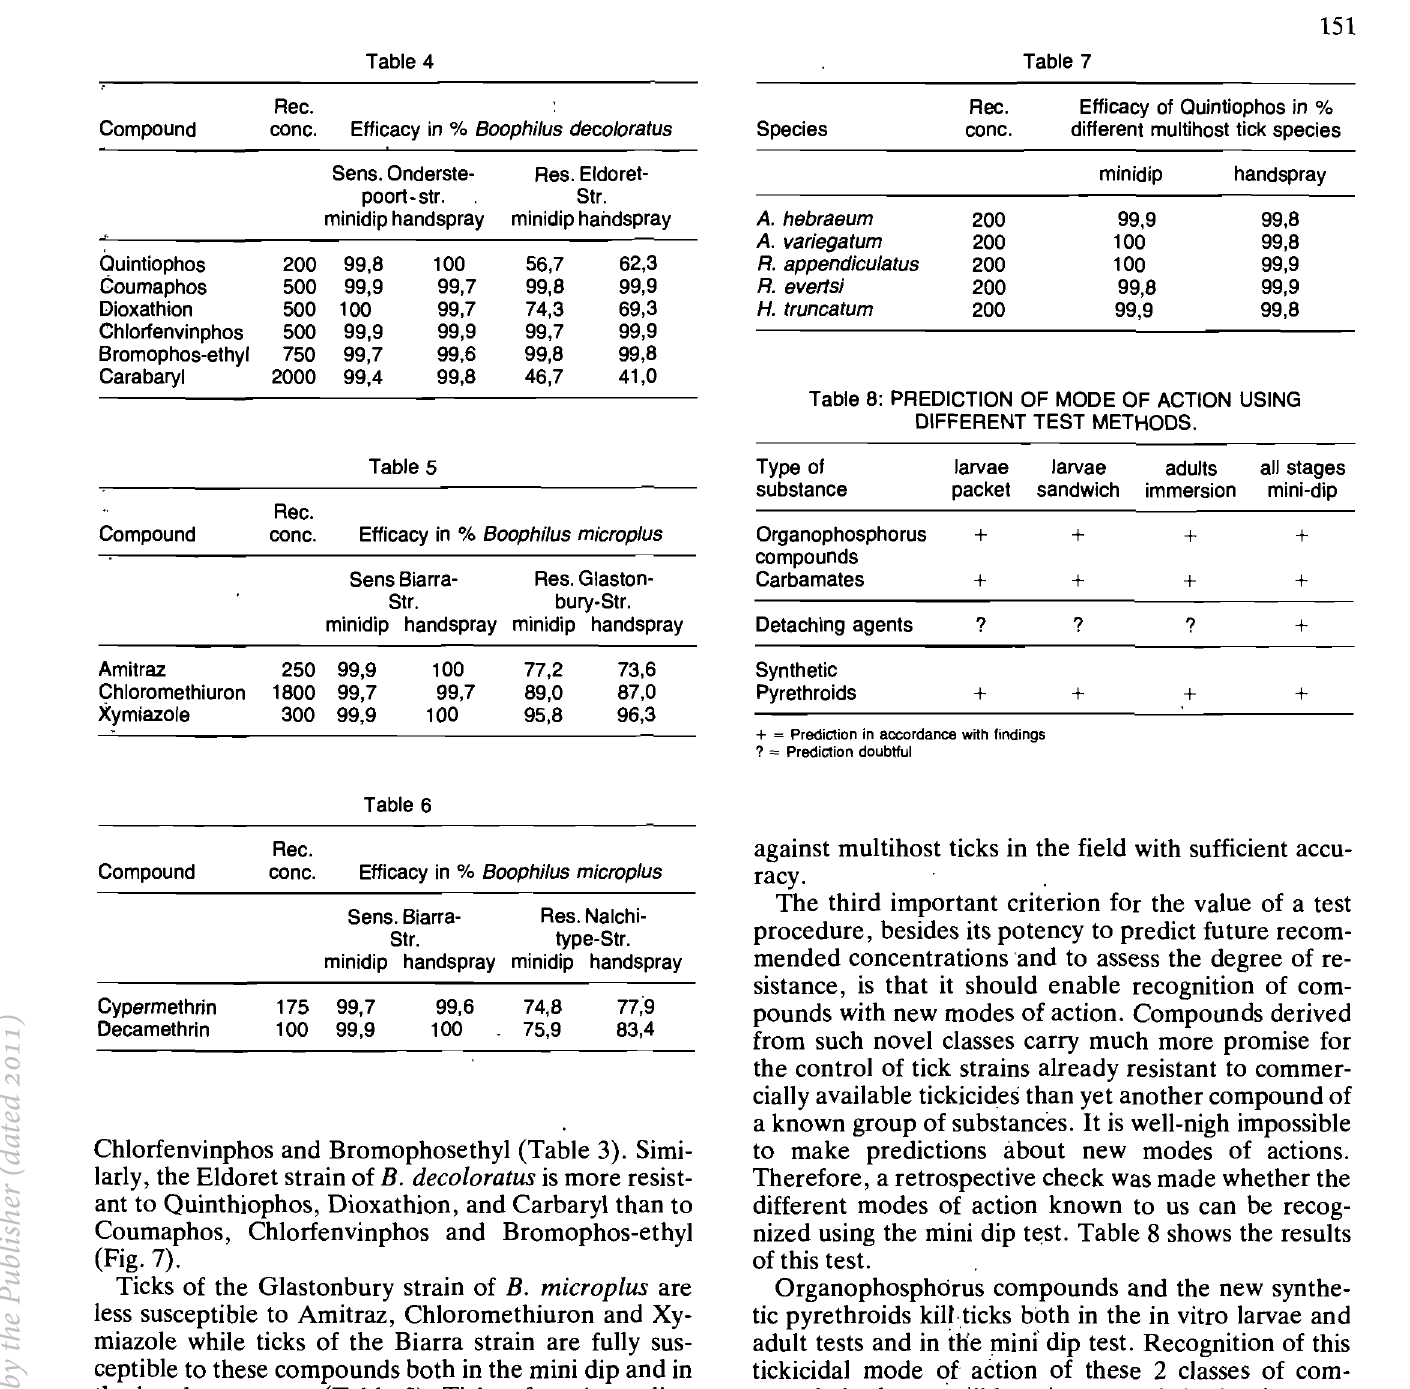
Table 8: PREDICTION OF MODE OF ACTION USING DIFFERENT TEST